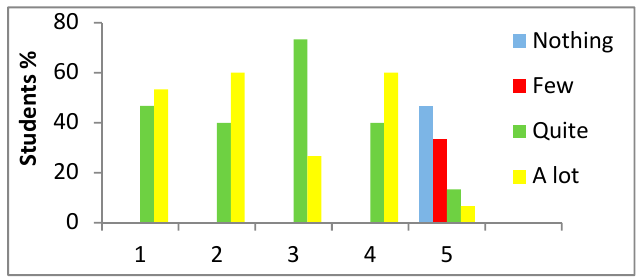
Figure 1. Scoring checklist for evaluating the utility of the Debate.